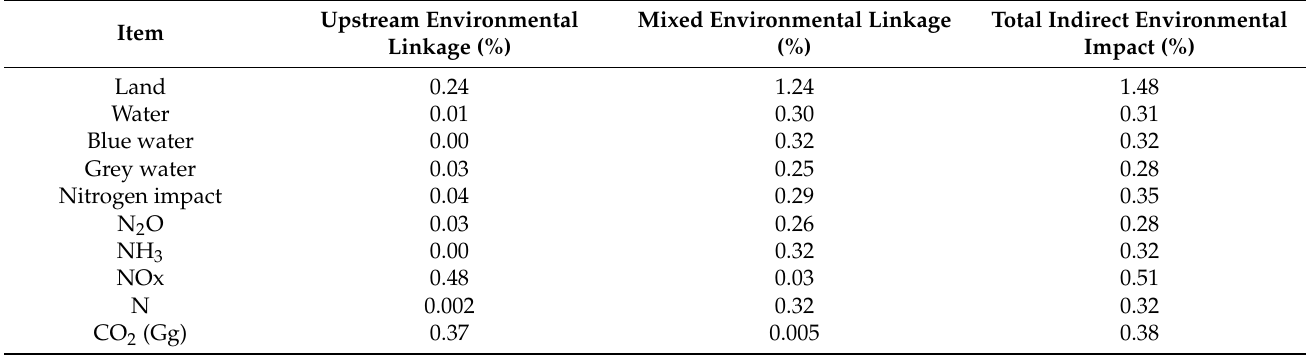
Table 3. The contribution of Pakistan’s agriculture sector’s indirect environmental impacts and sectoral linkages to total environmental impact of